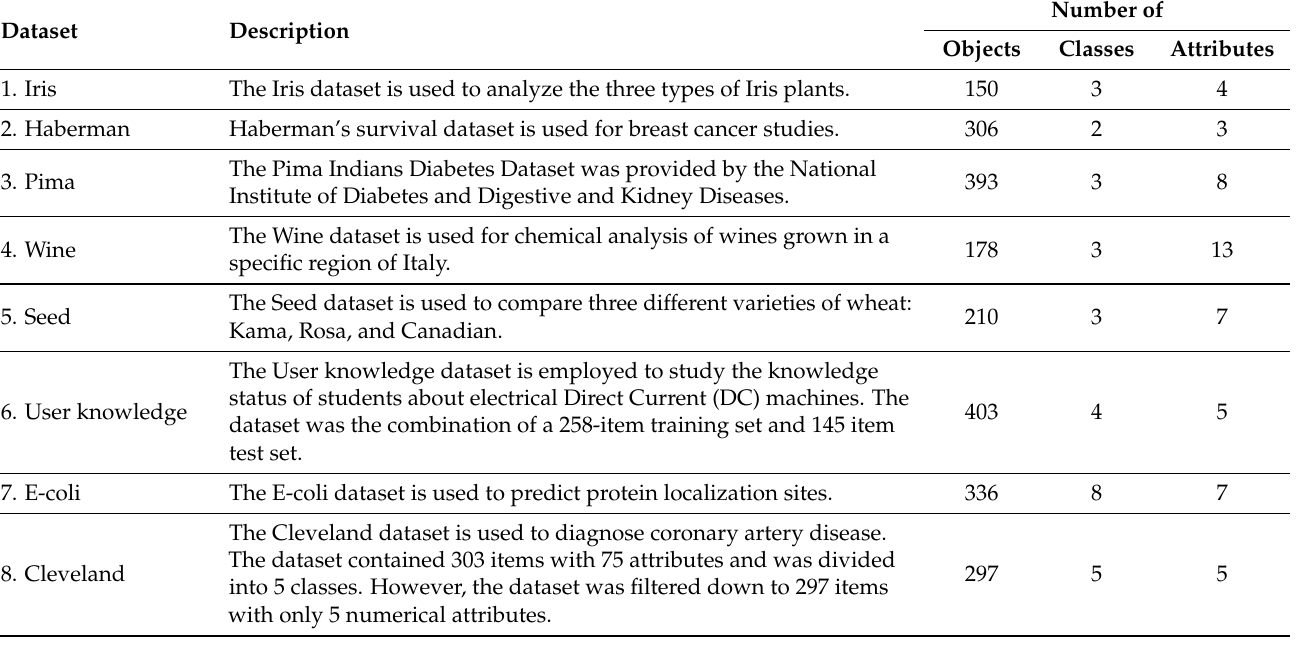
Table 1. Summary of Numerical